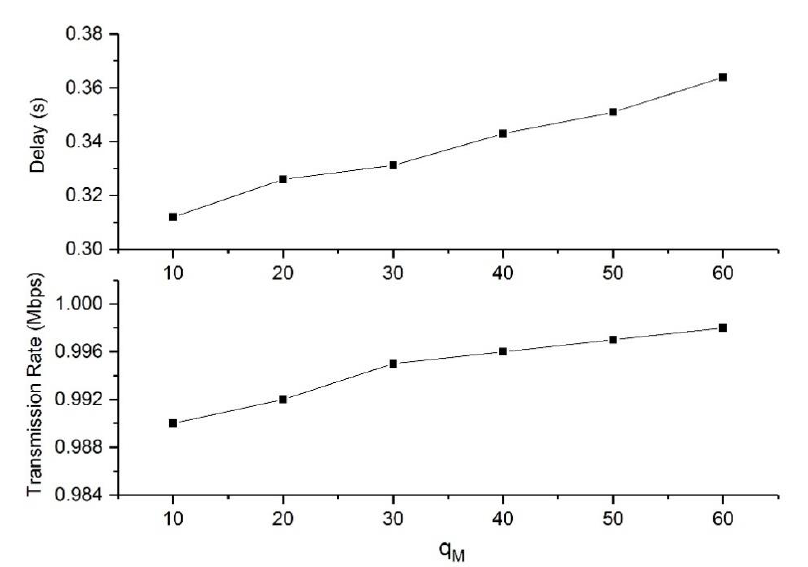
Figure 5. Network performance of DRDA versus the value of q M .